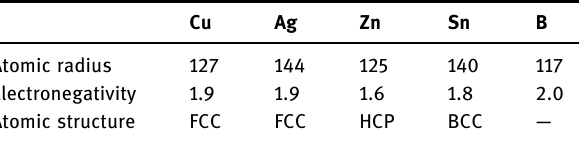
Table 3: Atomic radius ( pm ) , electronegativity, and atomic structure of the elements in the fi ller metal